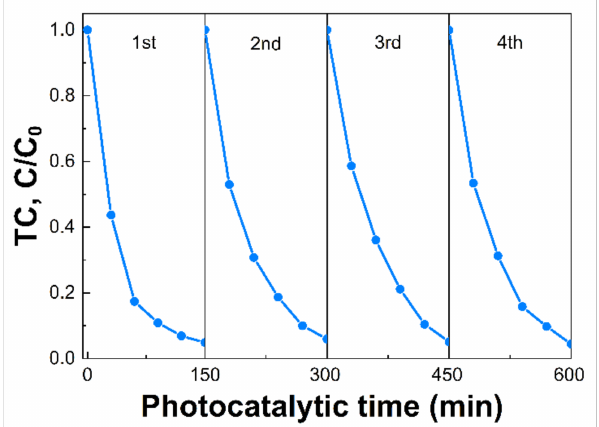
Figure 8. Recycling ability evaluation of